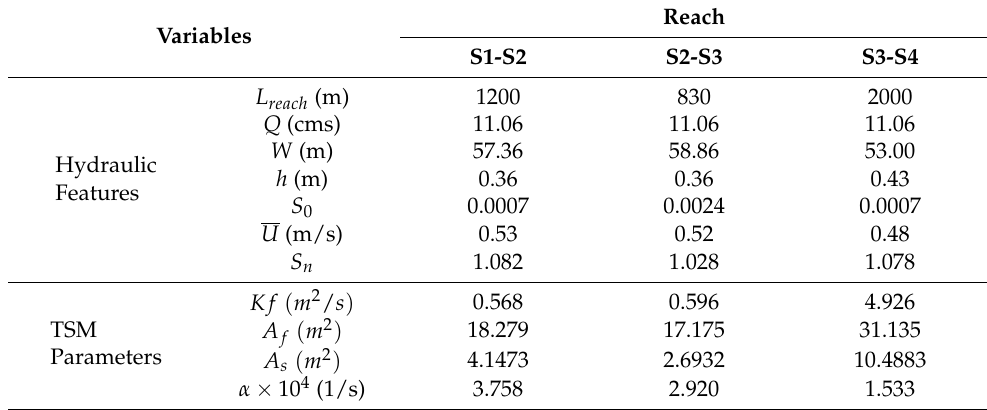
Table A1. Measured hydraulic features and estimated TSM parameters in the Gam-Creek tracer